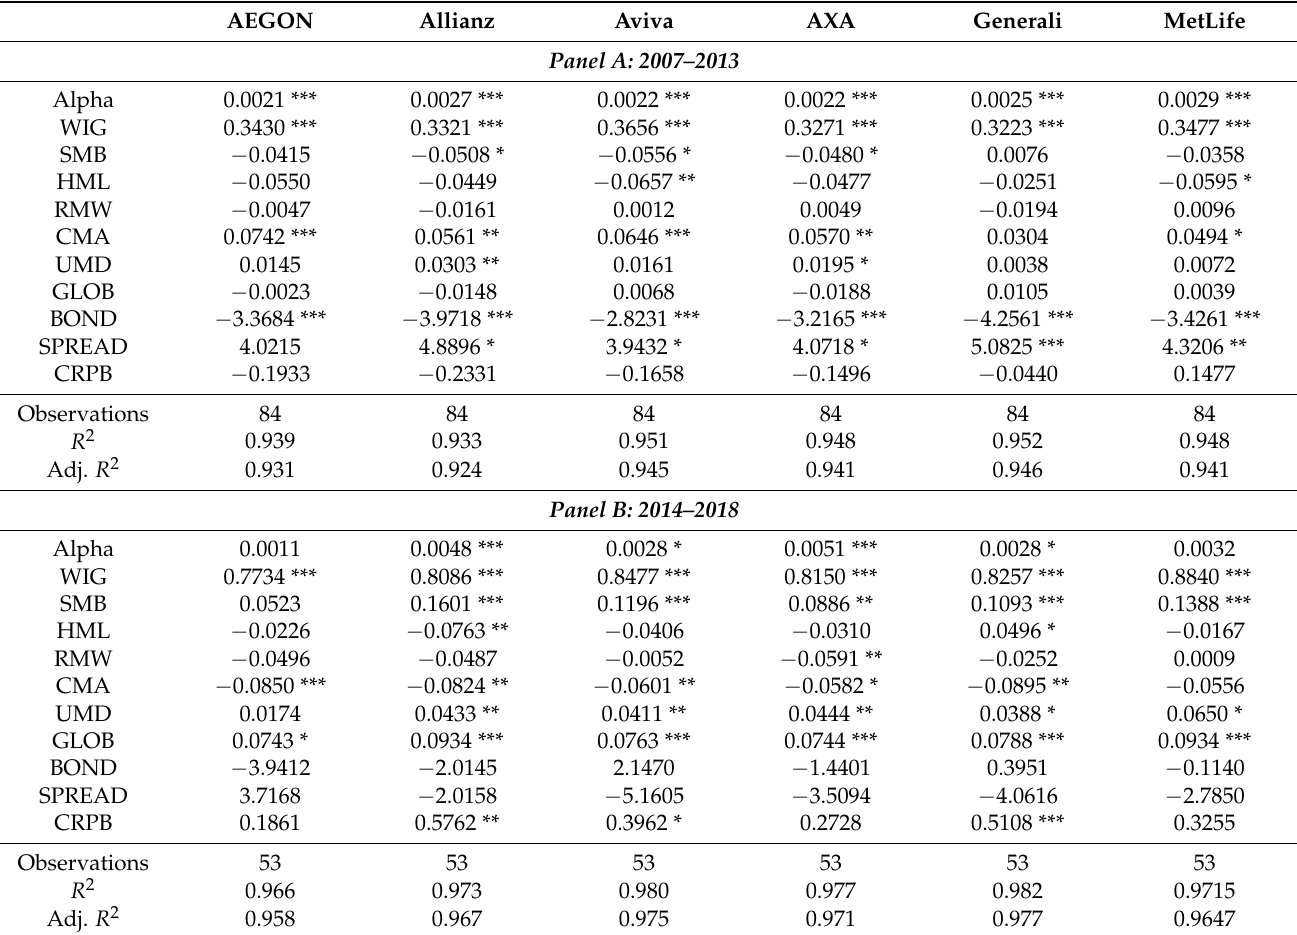
Table 5. Performance of individual OPF portfolios (part 1).